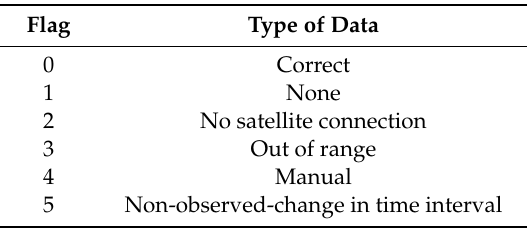
Table 2. Di ff erent flags in data Table 2. Different flags in data records.